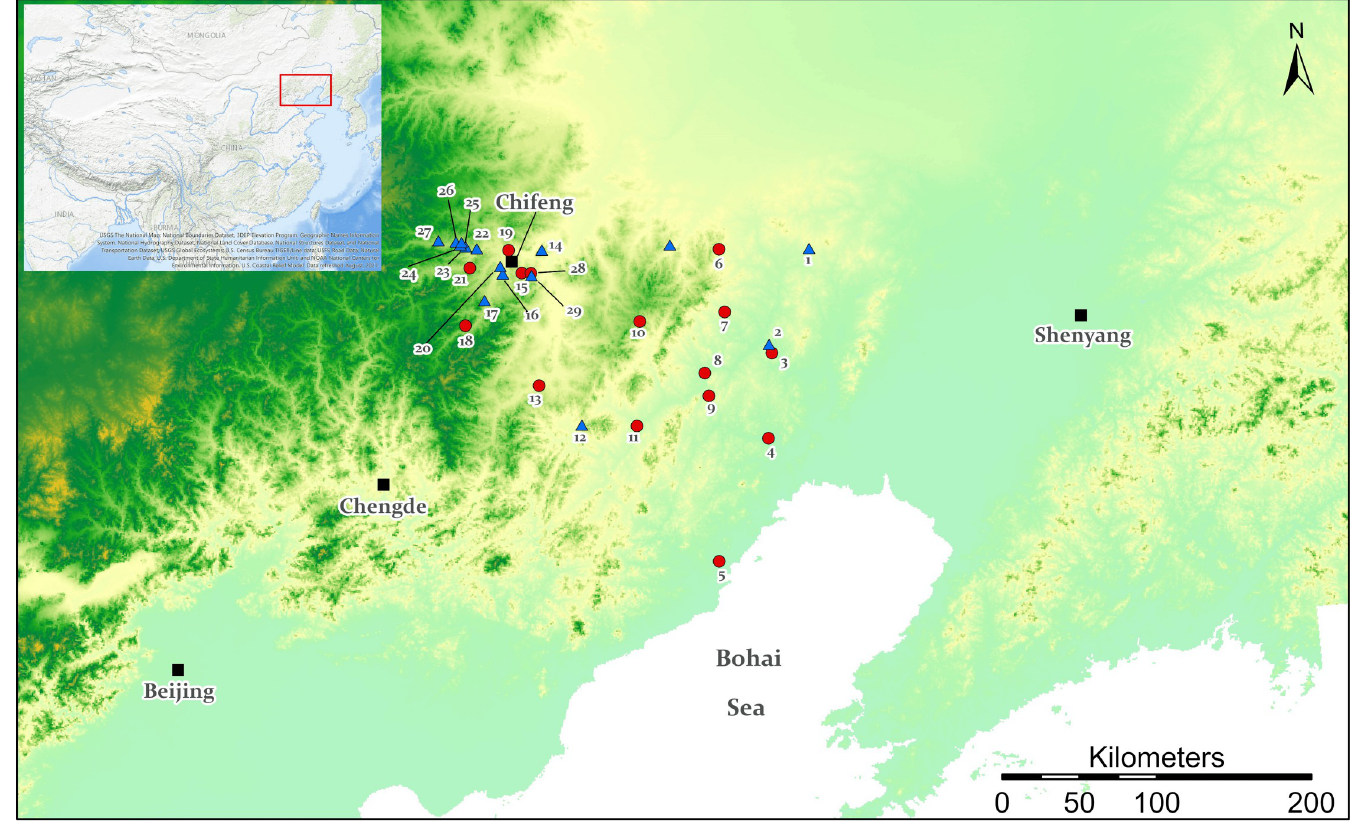
Fig 1. A map illustrating the distribution of excavated LXJD sites with radiocarbon dates. Map was produced in ArcGIS Pro. The digital elevation model was acquired from the Geospatial Data Cloud site, Computer Network Information Center, Chinese Academy of Sciences (http://www.gscloud.cn). 1. Pingdingshan